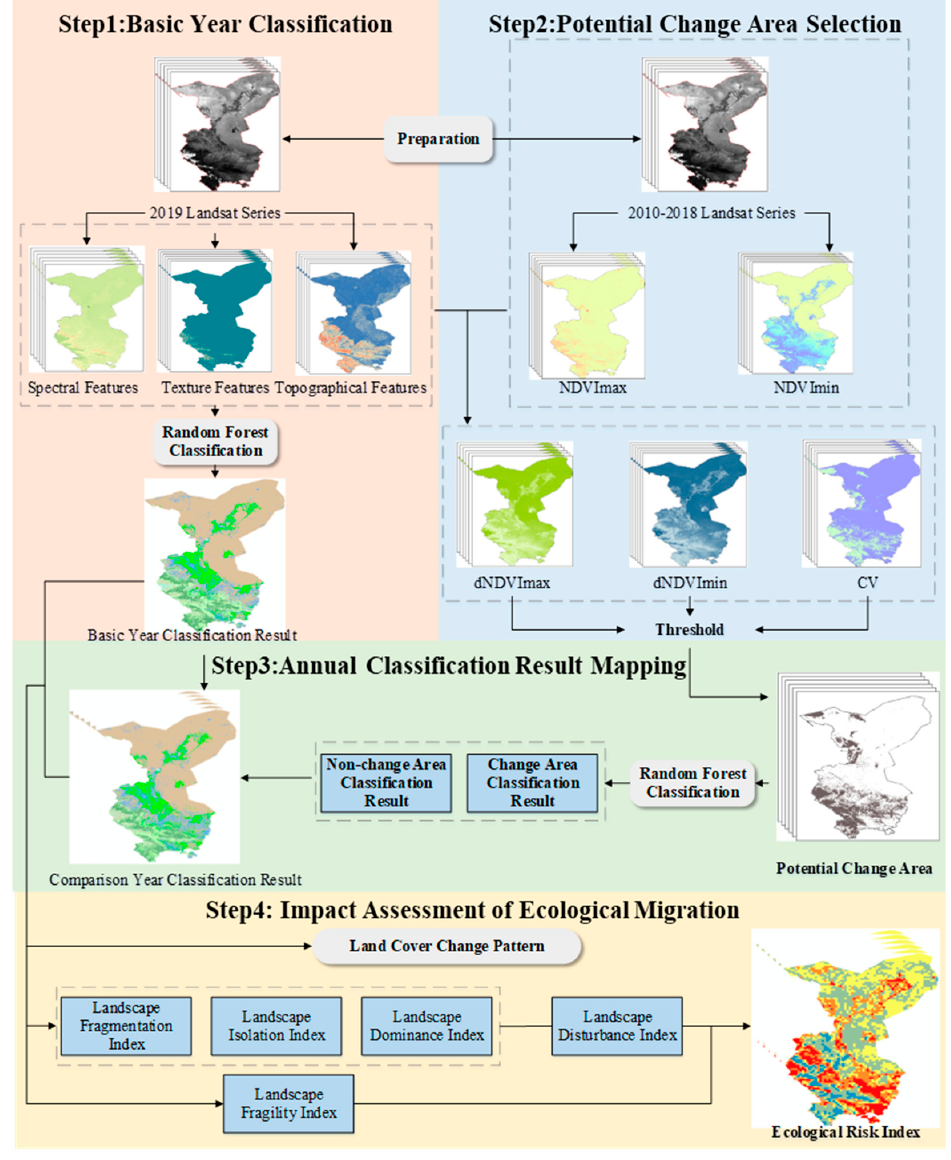
Figure 3. The workflow of this